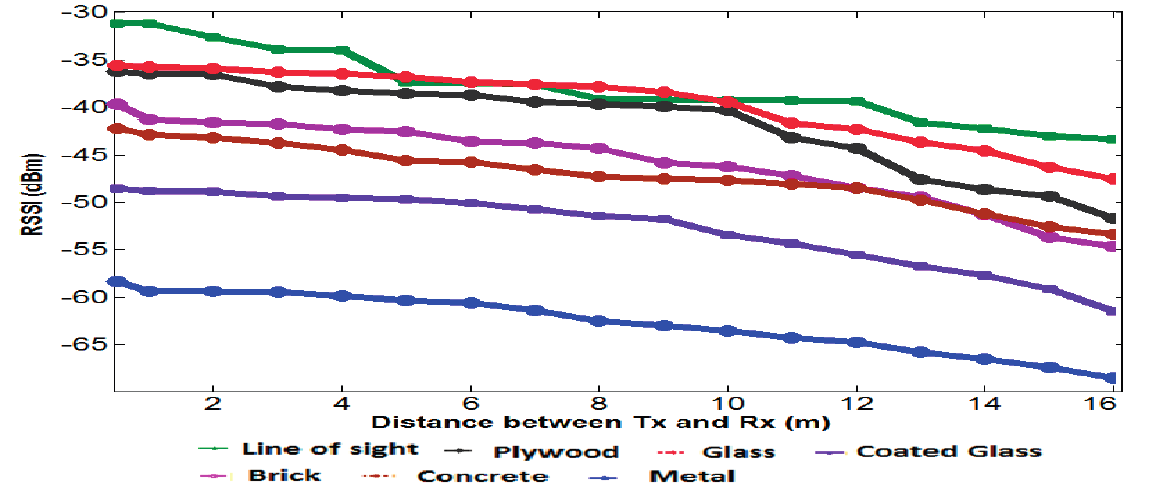
Figure 16. Attenuation loss caused by different materials in the smart building, measured between transmitter and